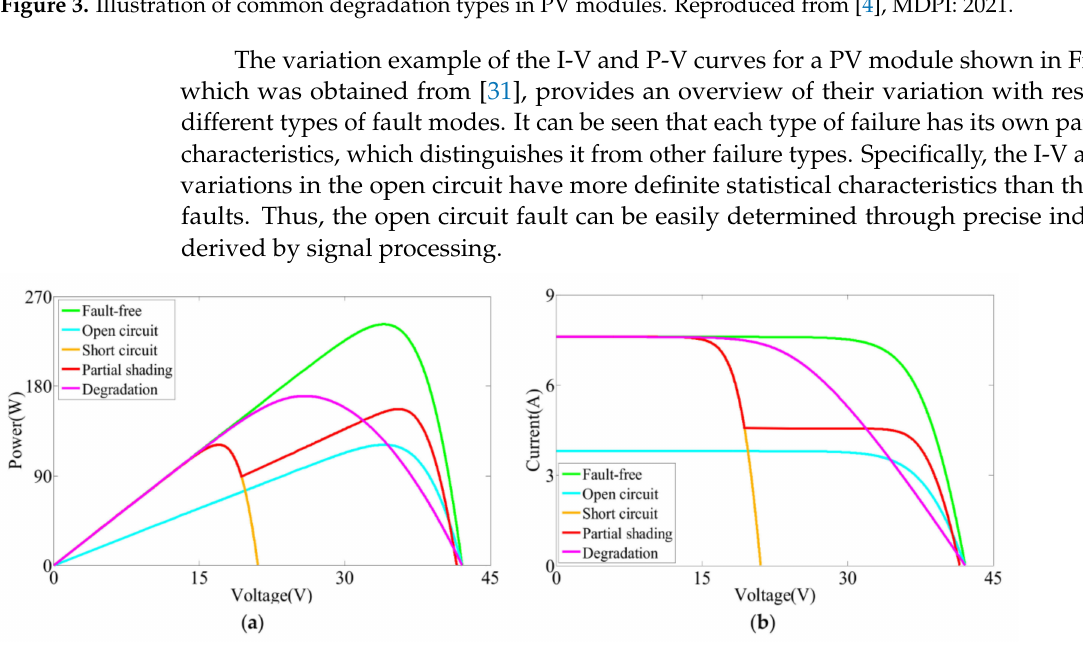
Figure 4. I-V and P-V curves for different fault types: ( a ) P-V curves; ( b ) I-V curves. Reproduced from [31], MDPI: